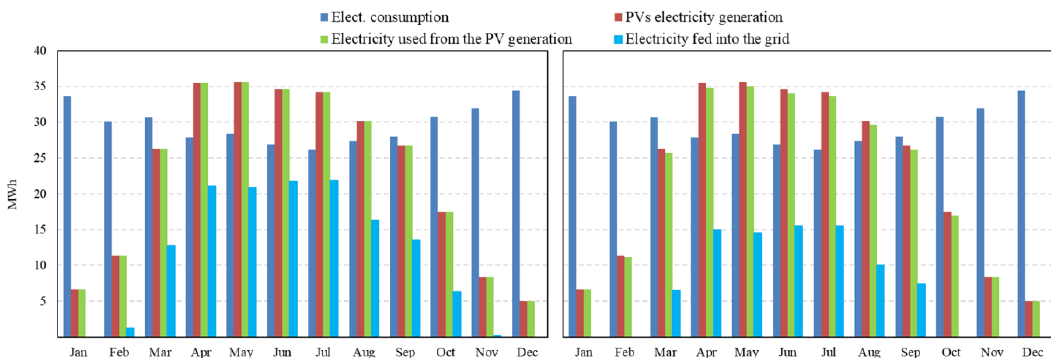
Figure 15. Monthly electricity consumption, the output of the PV system, electricity used from PV output, and electricity fed into the grid. Fore: feed-in tariff =6.7 ₵ /kWh and battery capacity = 0 ( left ), and feed-in tariff =3.35 ₵ /kWh and battery capacity = 183 kWh ( right ). Annual saving target 75%.